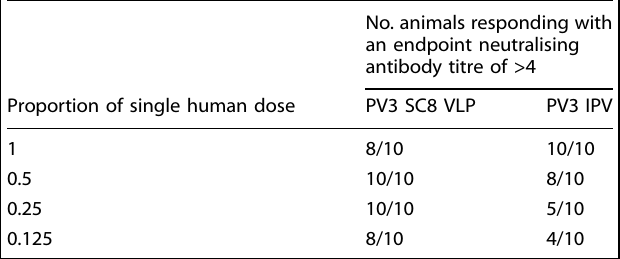
Table 2. Seroconversion in rats immunised (i.m.) with PV3 SC8 VLP or